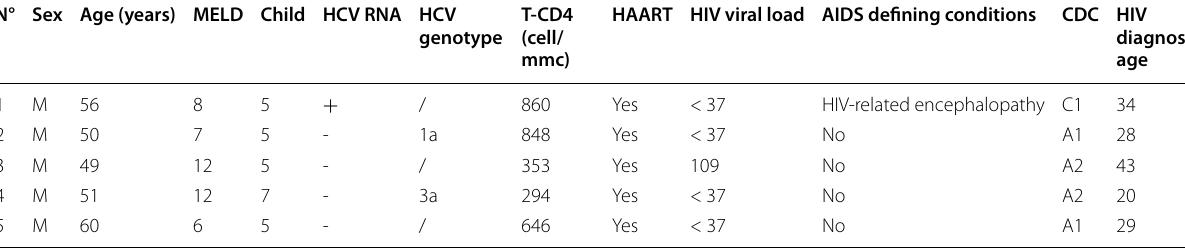
CDC Centers for Disease Control and Prevention classification